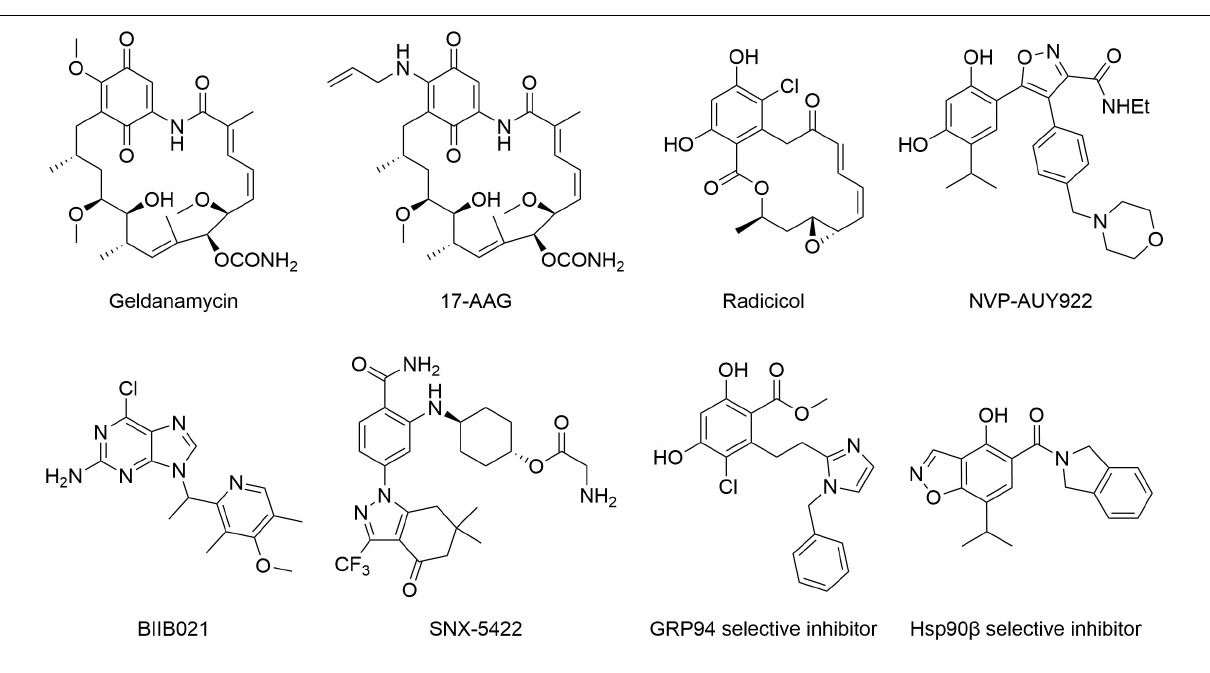
FIGURE 3 | Structures of Hsp90